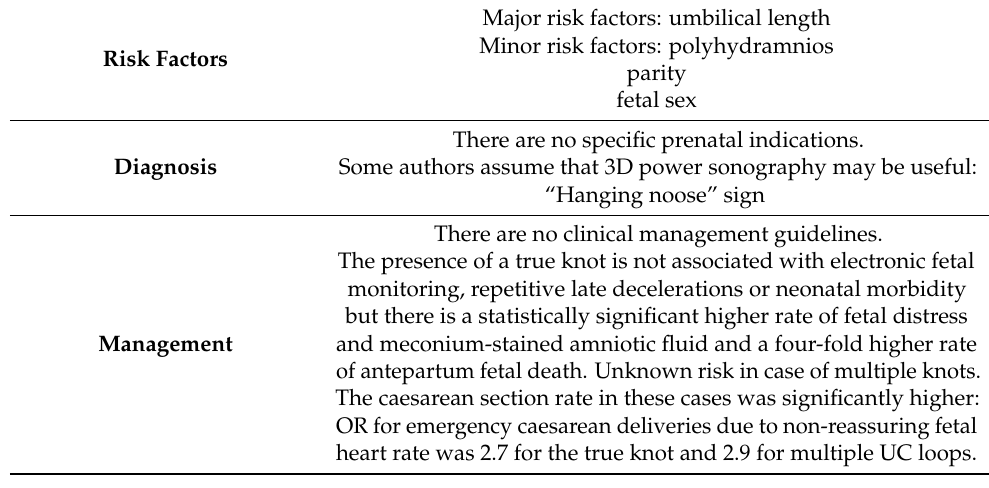
Table 1. Summary from the